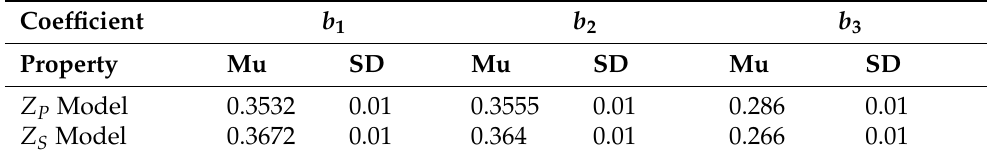
Figure 13. The trace plots of the Markov chains that simulate the coefficients of the variables for the Z S statistical model: b1, b2, and b3. Table 1. The statistical properties, mean (Mu) and standard deviation (SD), of the coefficients of the zero-offset Z P and Z S statistical